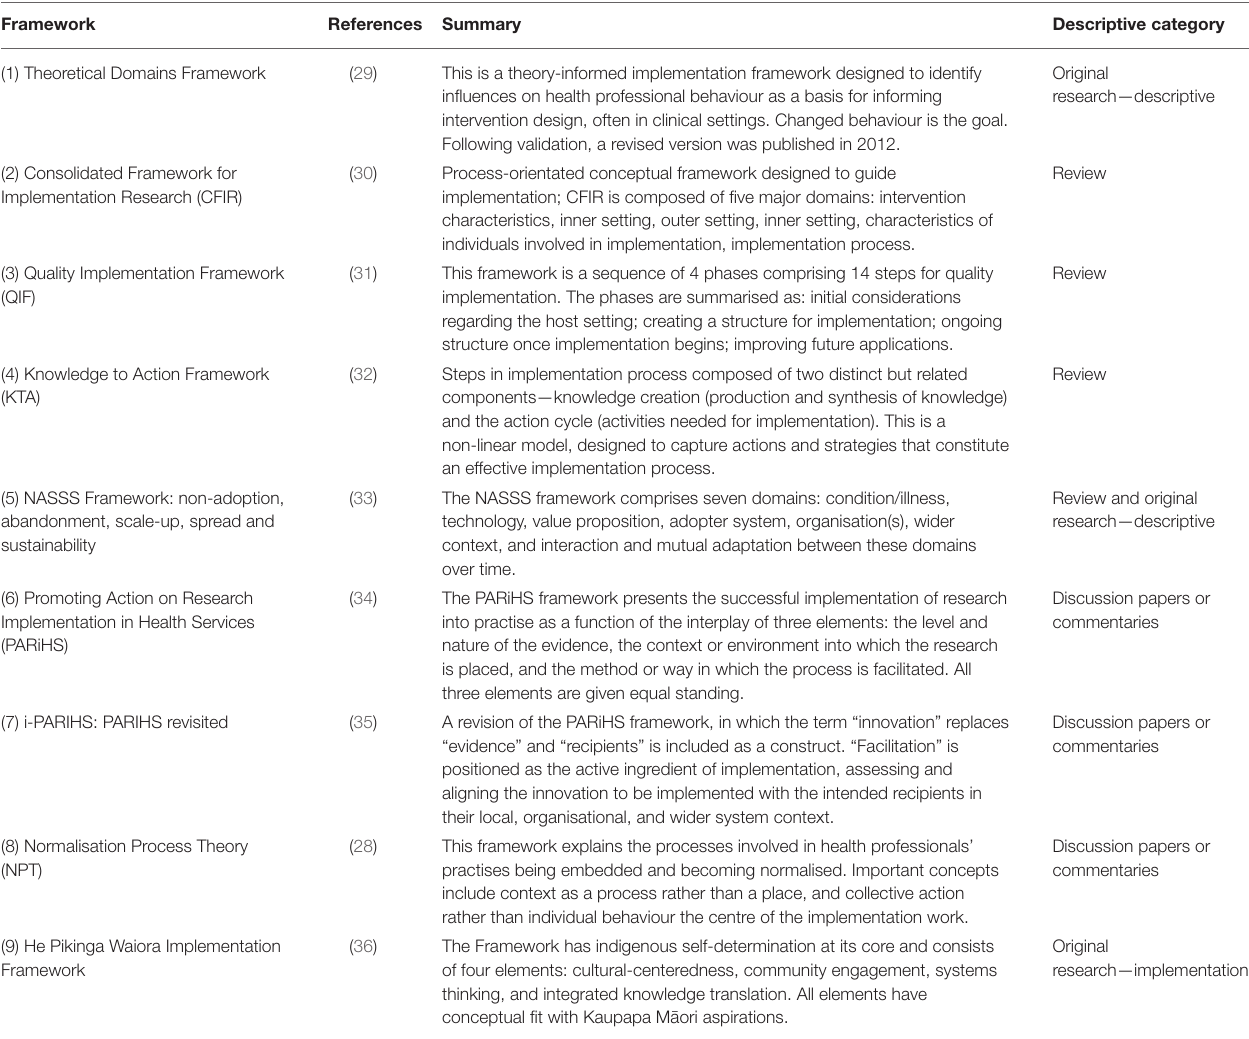
TABLE 2 | Primary frameworks literature selected for